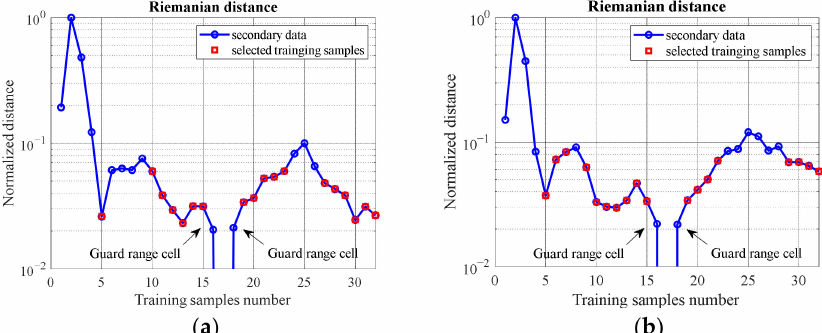
Figure 7. Riemannian distance between the cell under test (CUT) and other range cells (the points marked with square sign represent the selected training samples). ( a ) Negative Doppler frequency region (for targets 1 and targets 2). ( b ) Positive Doppler frequency region (for target 3 and target 4). The angle-Doppler and range-Doppler maps are demonstrated in Figure 8. Figure 8b,d denotes the angle-Doppler map and range-Doppler map after clutter suppression, respec- tively. Compared with Figure 8a,c, processed using 2-dimensional fast Fourier transform and digital beamforming (FFT–DBF) and set as the reference, it is obvious that the broad- ened first-order sea clutter has been suppressed and targets submerged in the clutter appear. SCNR Improve = SCNR after − SCNR before ( dB ) .